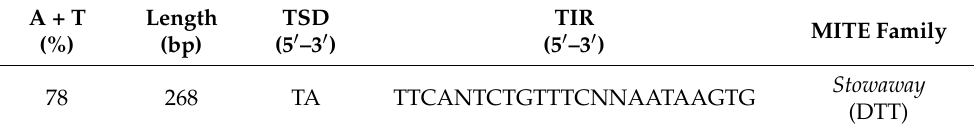
Table 3. The structural characteristics of PTE-2 .